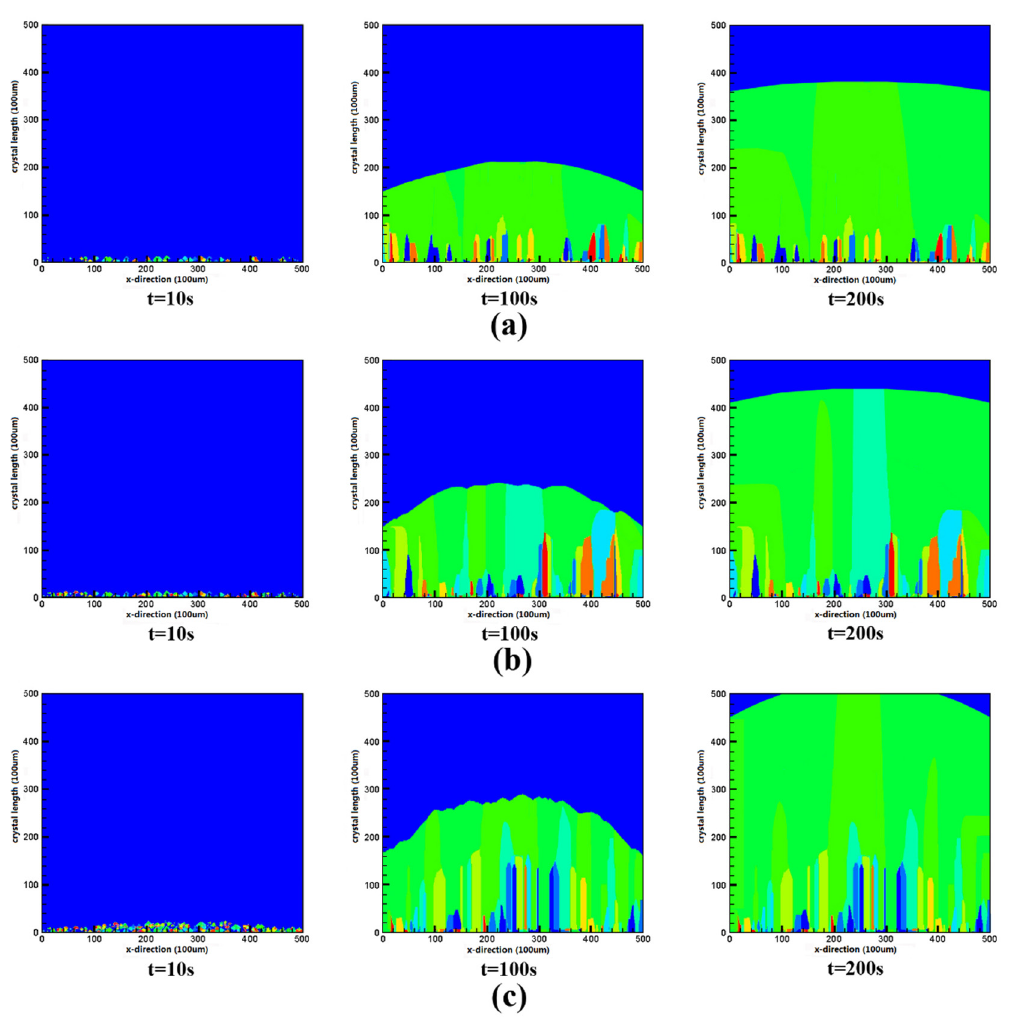
Figure 8. Crystal growth with different heat transfer coefficient at the bottom boundary: ( a ) 750 W · m − 2 · K − 1